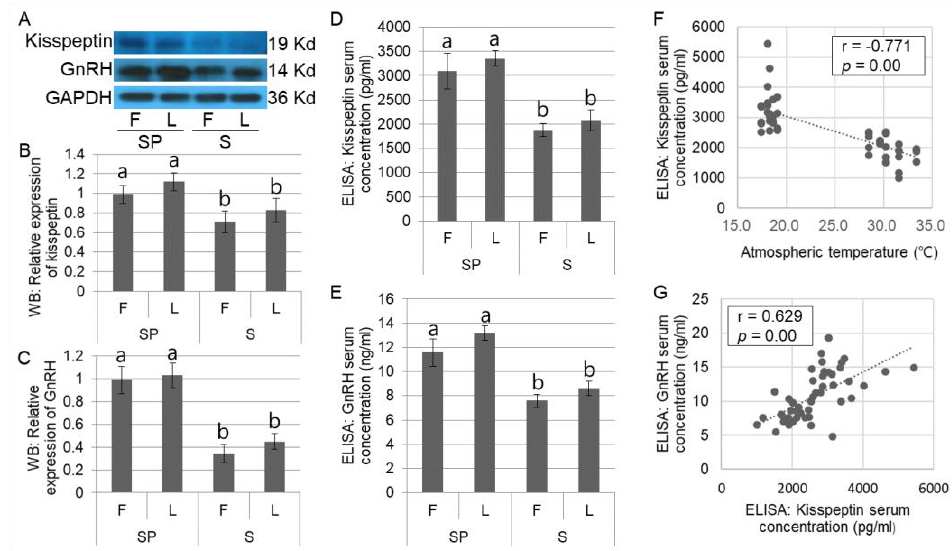
Figure 3. Expression of the hypothalamic kisspeptin and its downstream hormone (GnRH) in domestic sows in different seasons. The representative images for Kisspeptin, GnRH, and GAPDH in Western blotting assay are presented ( A ). The hypothalamic kisspeptin expression was significantly ( p < 0.05) reduced in the summer group than in the spring group ( B ). GnRH expression is consistent with the results of those of kisspeptin expression ( C ). In the ELISA assay, significant ( p < 0.05) reductions of kisspeptin and GnRH in the serum were observable in the summer group, relative to the spring group ( D , E ). A highly negative correlation between kisspeptin expression and the atmospheric temperature (r = − 0.771) or a positive correlation with the reduced kisspeptin and GnRH concentration (r = 0.629) is demonstrated ( F , G ). The Western blotting ( A – C ) is conducted using 32 samples ( n in SP = 16 and n in S = 16), and the results by ELISA ( D – G ) are obtained from 50 domestic sows ( n in SP = 25 and n in S = 25). Different letters at the top of the bars indicate significant differences ( p < 0.05) among groups. Graphs are presented as mean ± SEM. Abbreviation: GnRH, gonadotropin-releasing